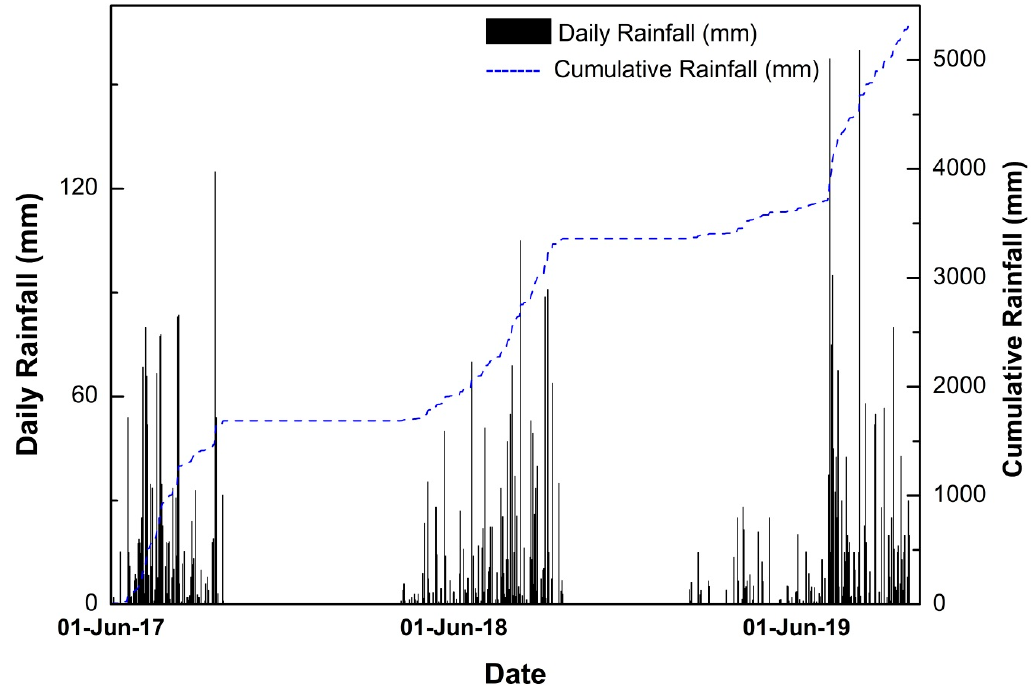
Figure 6. Time history of hourly and cumulative rainfall for the study period.